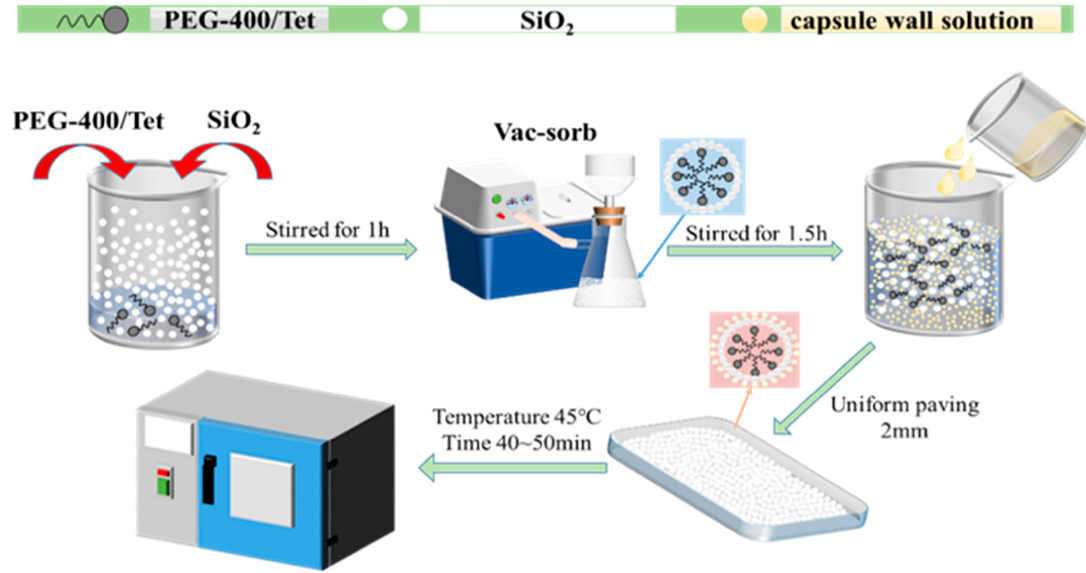
Figure 1. Preparation process for composite shaped PCM.